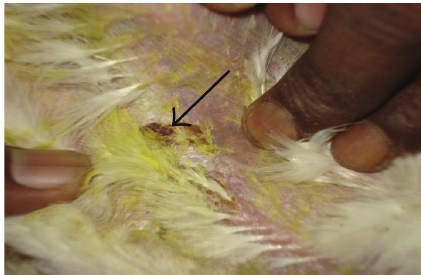
Figure 9: DTH reaction of skin (T-2 toxin plus SBT 800 ppm plus GM fed bird): severe increase in skin thickness, erythema, ulceration, induration, and large area of scab formation compare to toxin fed